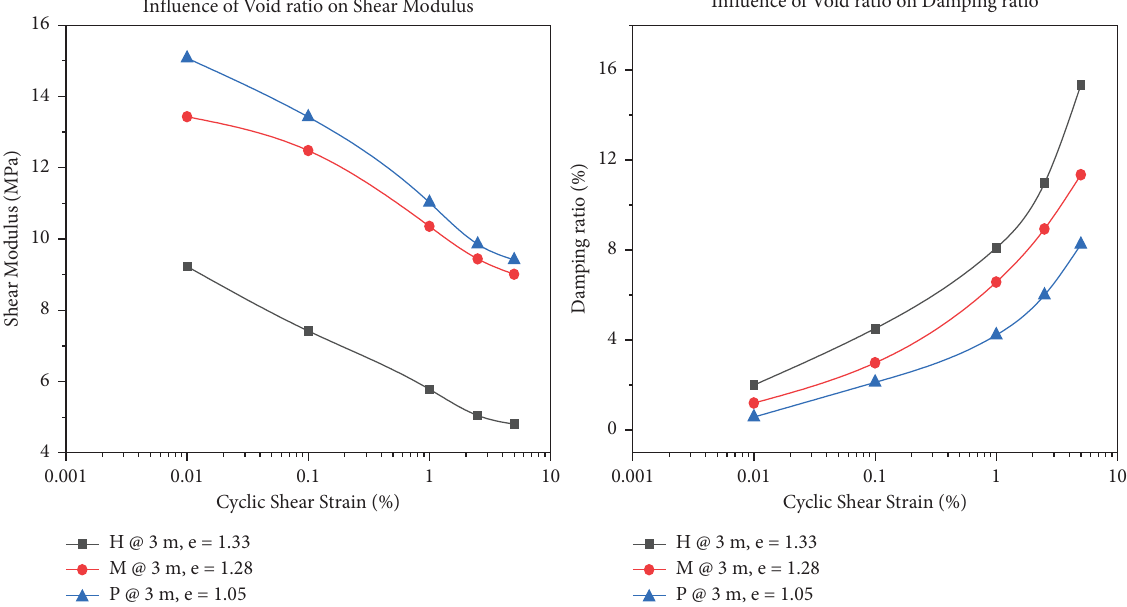
Figure 10: Infuence of void ratio on shear modulus and damping ratio values at 5 th cycle and 400